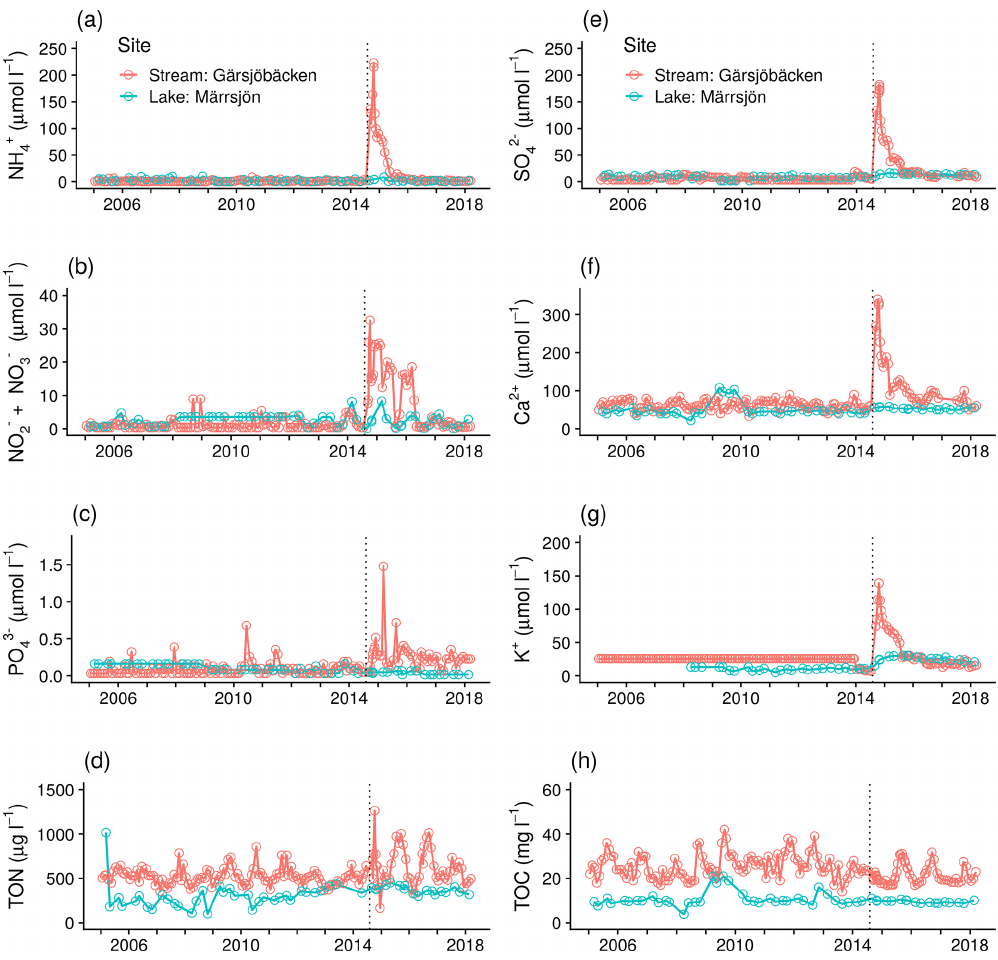
Figure 4. Long-term (13 years) changes in concentration of nutrients and major elements in Gärsjöbäcken and Märrsjön catchments: + NO − (a) NH + , (b) NO − , (c) PO − 3 , (d) total organic N, (e) SO − 2 , (f) Ca 2 + , (g) K + , and (h) total organic C (TOC). Dashed vertical 4 2 3 4 4 lines indicate the time of the fire. Note that the limit of detection for K + at Gärsjöbäcken was 25µmolL − 1 prior to 2014.